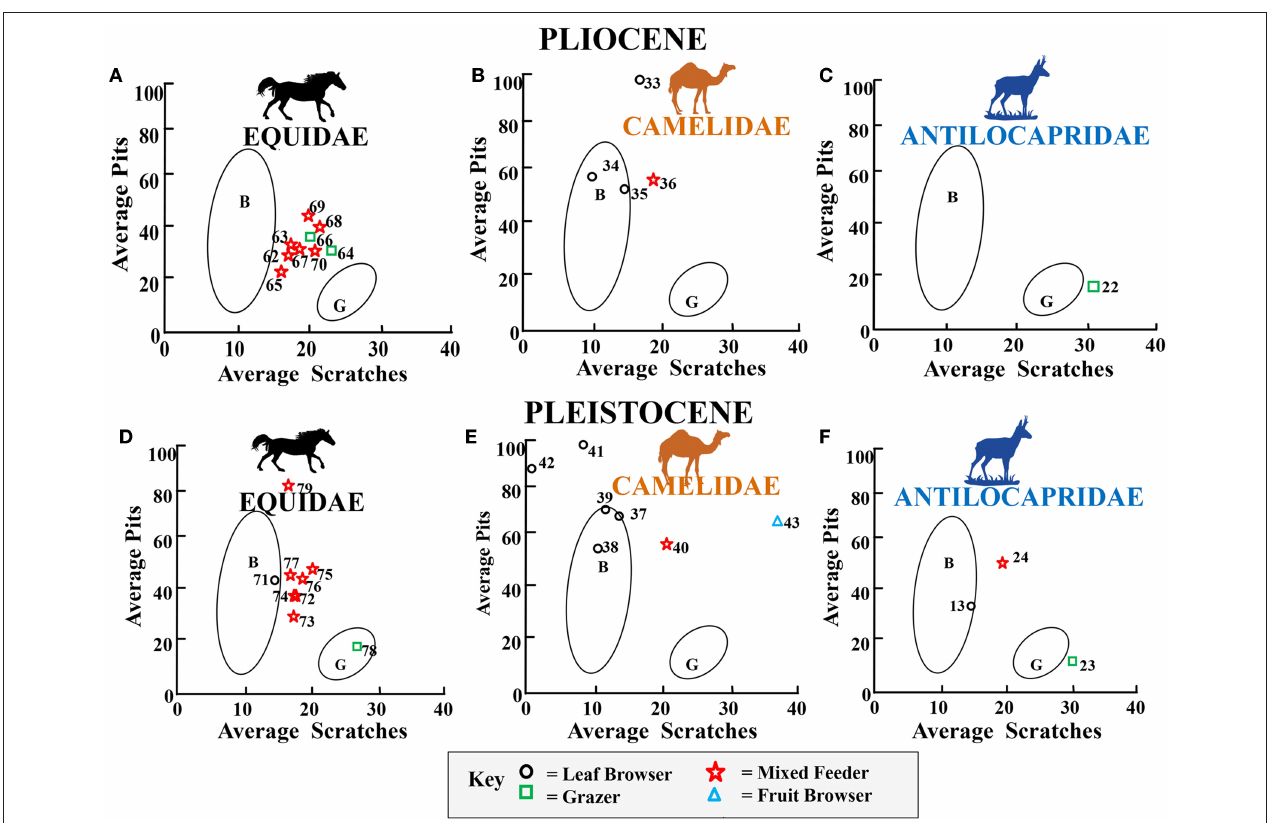
FIGURE 13 | Bivariate Plot showing results for the average number of pits vs. the average number of scratches per taxon for Pliocene and Pleistocene fossil equids (A,D) , camelids (B,E) , and antilocaprids (C,F) plotted in reference to extant leaf dominated ungulate browsers (B), and extant grazers (G) at 35 times magnification (extant comparative data from Semprebon, 2002 and Solounias and Semprebon, 2002). Gaussian confidence ellipses ( p = 0.95) on the centroid are indicated for the extant leaf browsers (B) and grazers (G) (convex hulls) adjusted by sample size. Key to Pliocene Equidae: = 62 = Nannipus aztecus , 63 = Pseudhipparion simpsoni , 64 = Neohipparion eurystyle , 65 = Cormohipparion emsliei , 66, 67 = Equus simplicidens , 68, 69 = Equus sp., 70 = Nannipus peninsulatus . Key to Pliocene Camelidae: 33, 34 = Megatylopus sp., 35 = Gigantocamelus spatula , 36 = Hemiauchenia sp. Key to Pliocene Antilocapridae: 22 = Tetrameryx sp. Key to Pleistocene Equidae: 71, 74, 78 = Equus sp., 72 = Equus sp. A, 73 = Equus ( Hemionus ) sp. “B,” 75 = Equus calobatus , 76 = Equus complicatus , 77 = Equus fraternus . Key to Pleistocene Camelidae: 37 = Camelops sp., 38, 39 = Camelops sp., 40 = Hemiauchenia macrocephala , 41 = Camelops nevadanus , 42, 43 = Palaeolama mirifica . Key for to Pleistocene Antilocapridae: 13 = Capromeryx furcifer , 23 = Hayoceros falkenbachi , 24 = Stockoceros onusrosagris